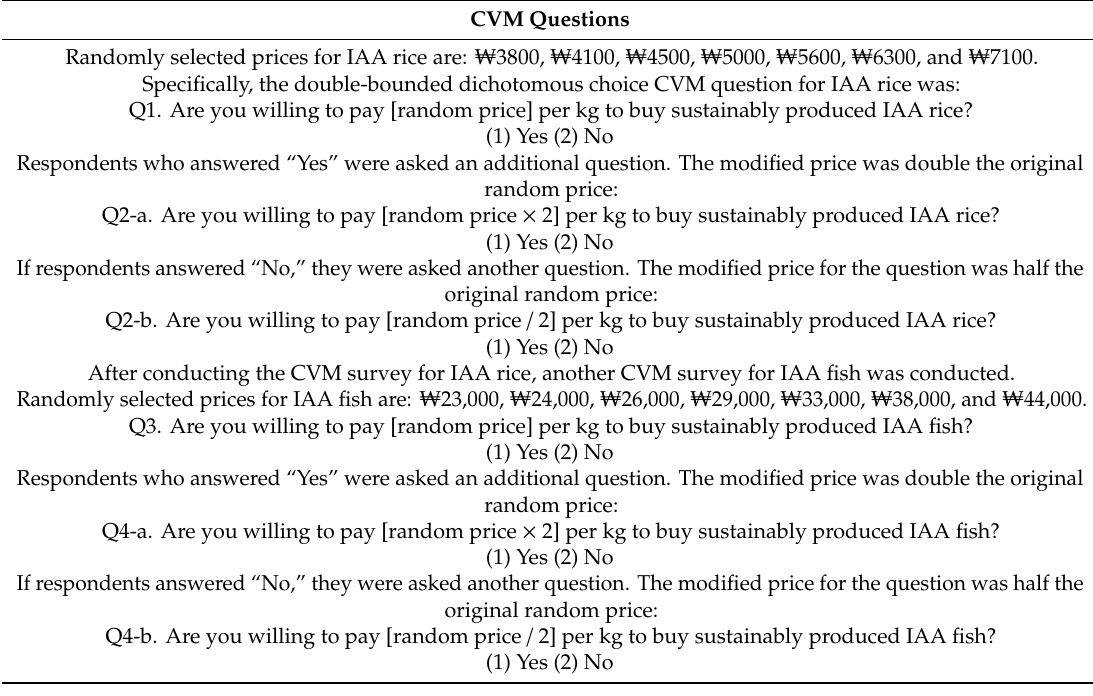
Table 2. Sample of CVM questions. CVM